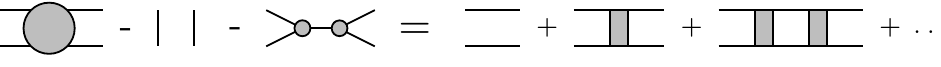
Figure 1 . Graphical representation of F s , combining (2.36), on the left-hand side, with (2.35) and (2.33), on the right-hand side. The grey disks with four and three legs represent the full four- point and three-point functions, respectively, while a grey rectangle, together with the two edges to its left, represents the Bethe-Salpeter kernel. For simplicity we have omitted the crossed graphs with X and X 3 4